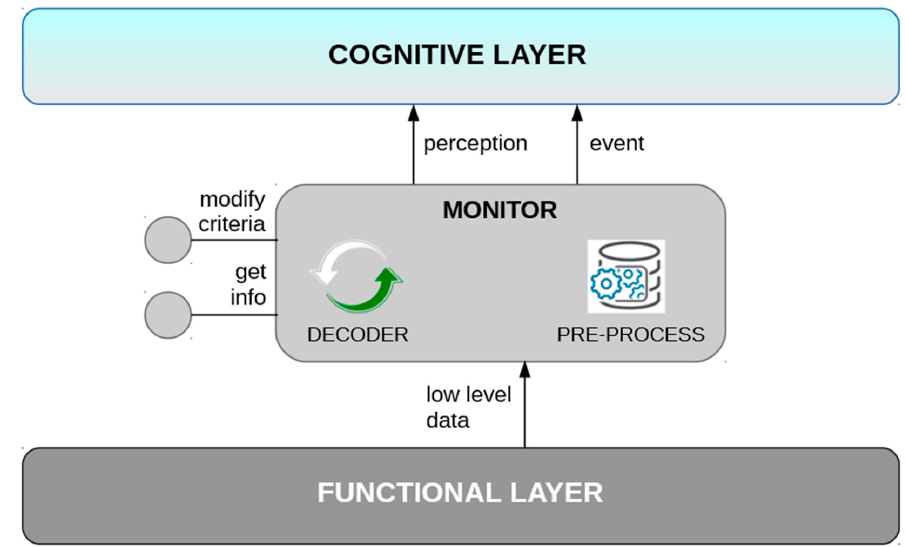
Figure 4. Monitor component (operative layer).